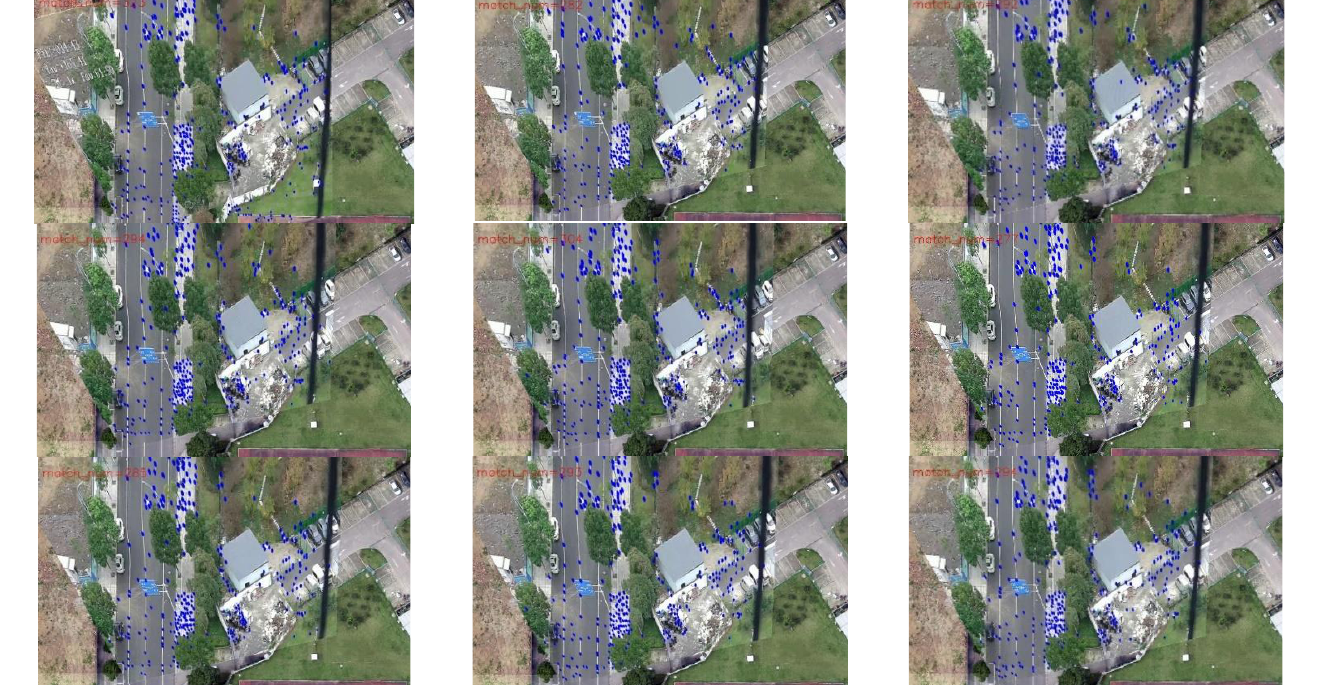
Figure 25. Registration image (after updating the map features). Table 7. Comparison of the number of matching points and 𝑖𝑛𝑑𝑒𝑥 values. The better results are highlighted in bold.